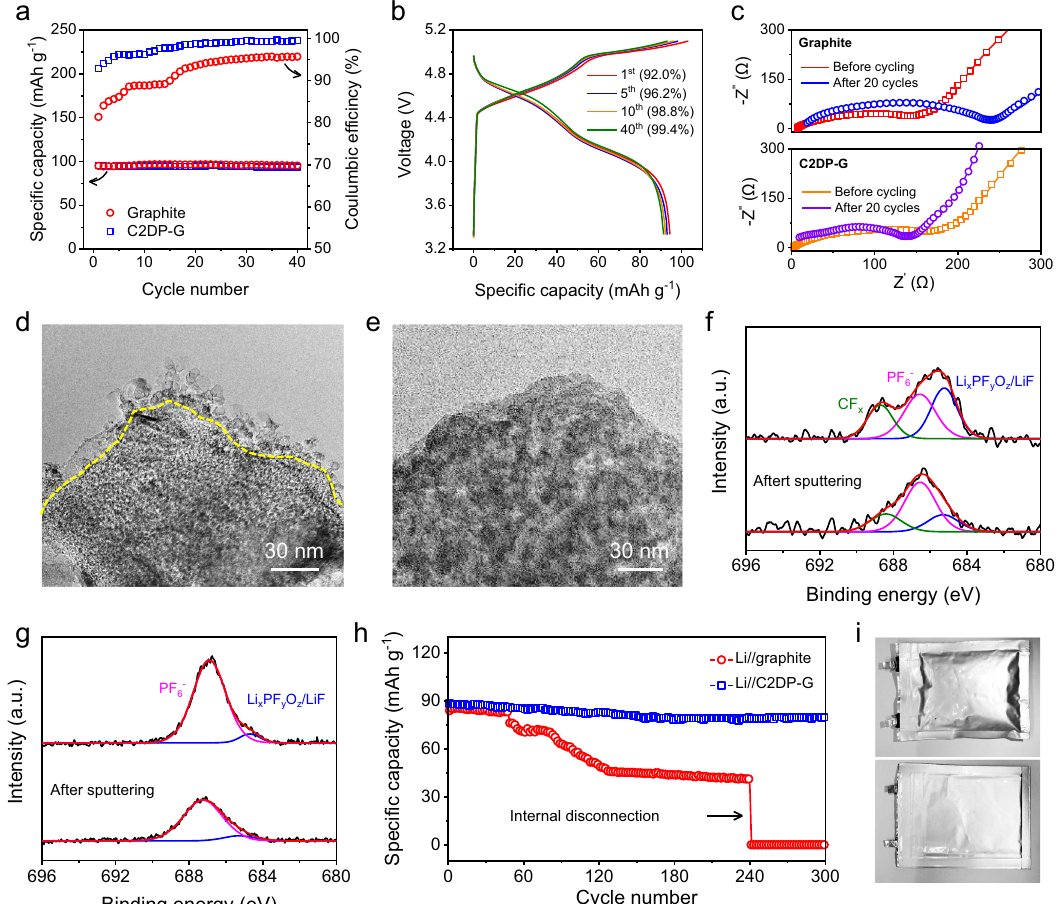
Fig. 3 | Analysis of electrolyte decomposition. a Speci fi c capacities and Cou- lombicef fi cienciesof the graphite electrodeand C2DP-G electrode inthe initial40 charge/discharge cycles at 1C. b The 1 st , 5 th , 10 th , 40 th GCD curves of the C2DP-G electrodeat1C. c NyquistplotsofthegraphiteelectrodeandtheC2DP-Gelectrode before and after20GCD cycles.TEMimagesof the graphitegrain in d the graphite